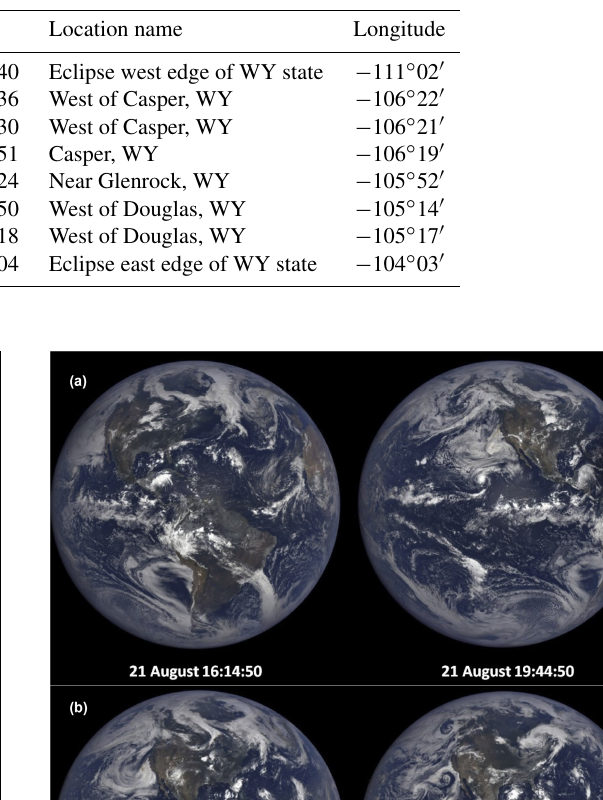
Table 1. Eclipse measurement timing and location details for five wavelengths. Eclipse maximum and EPIC image times. Total measurement duration: 2.7min.